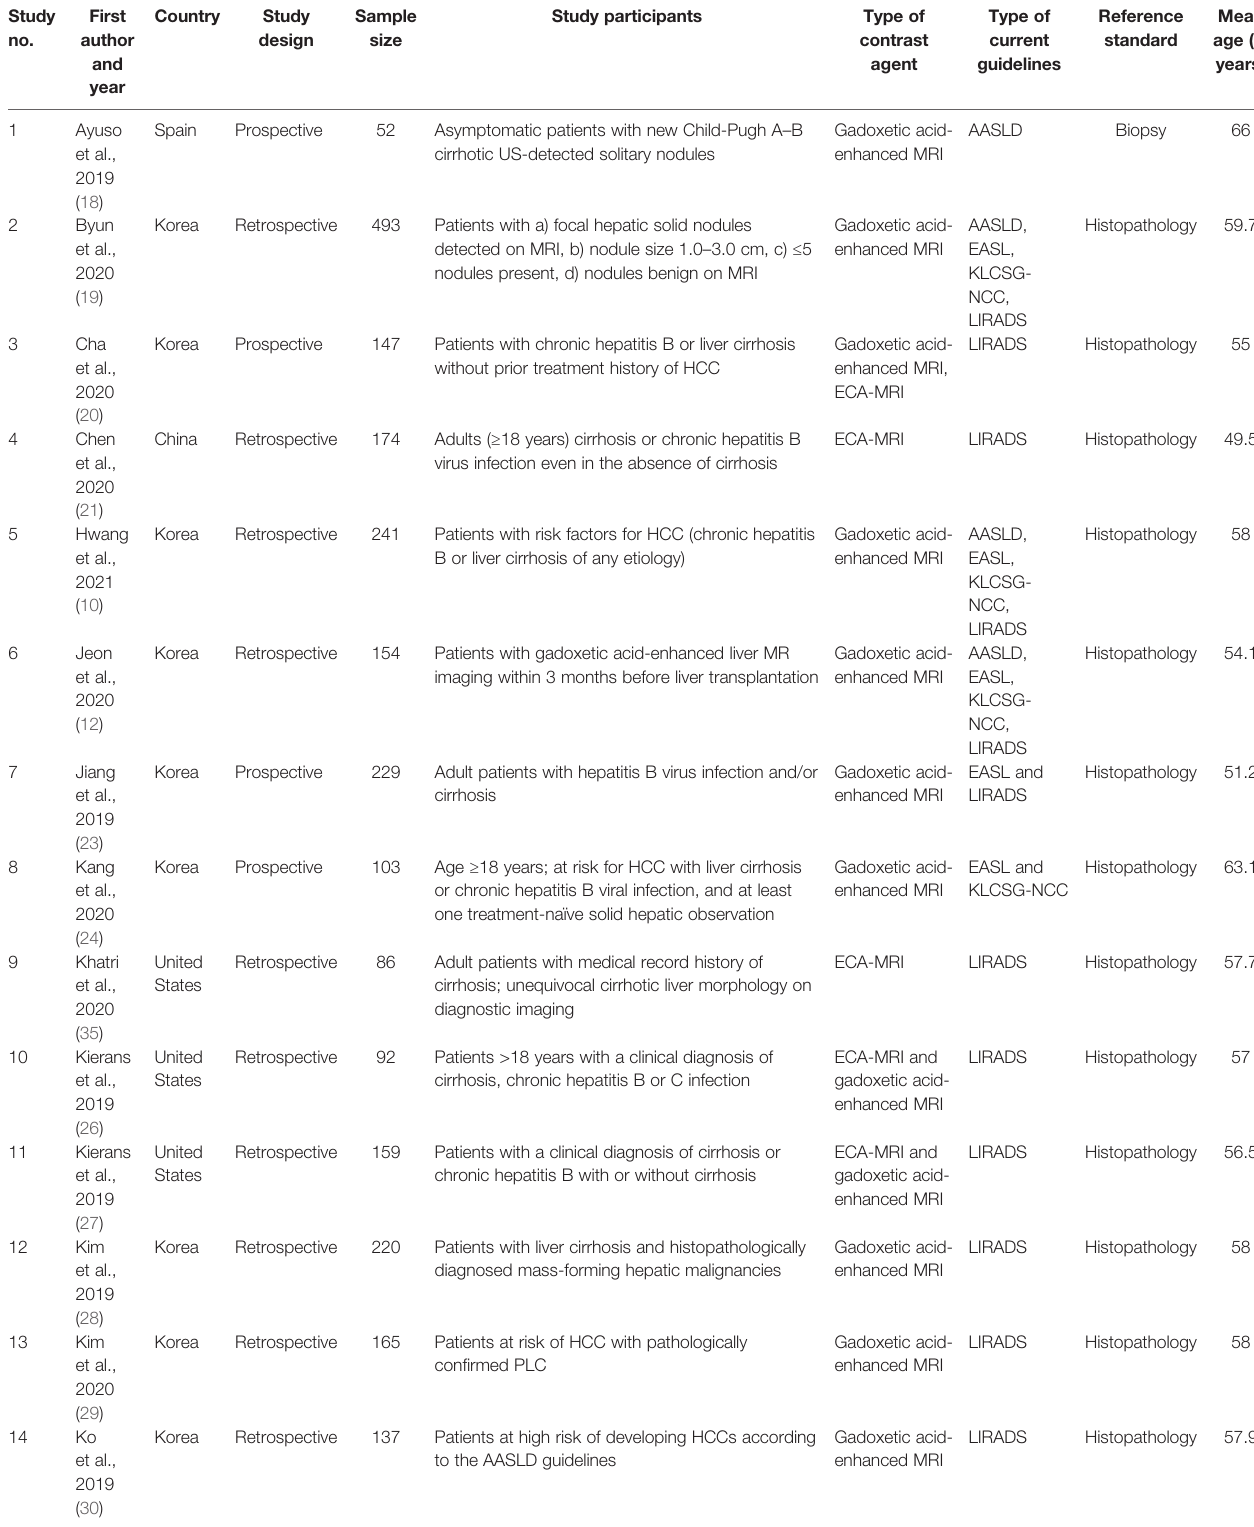
TABLE 1 | Characteristics of the included studies (n = 21). Study